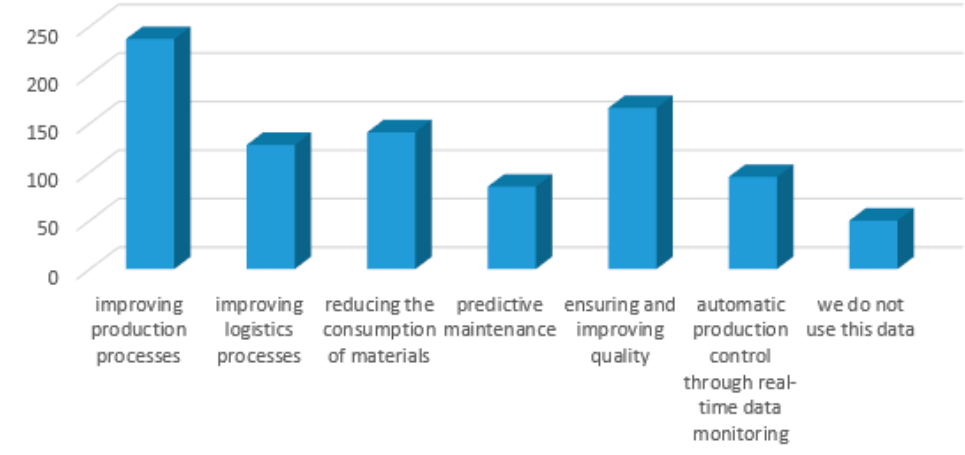
Figure 6. Areas of use of data obtained from processes.